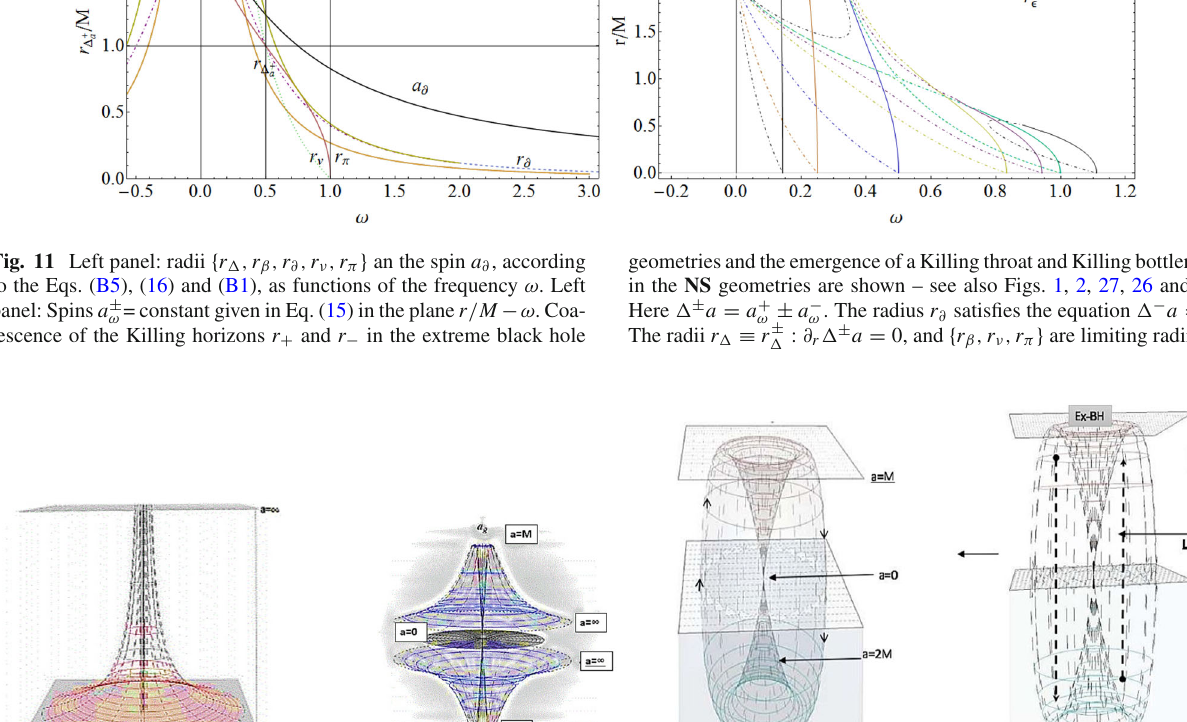
own-up-arrow indicates the relation NS – BH , defining the outer horizon r + . An up-down arrow determines the inner horizons, which are totally included in the BH . The limiting cases a = 0, a = M , a = 2 M and a = ∞ are also